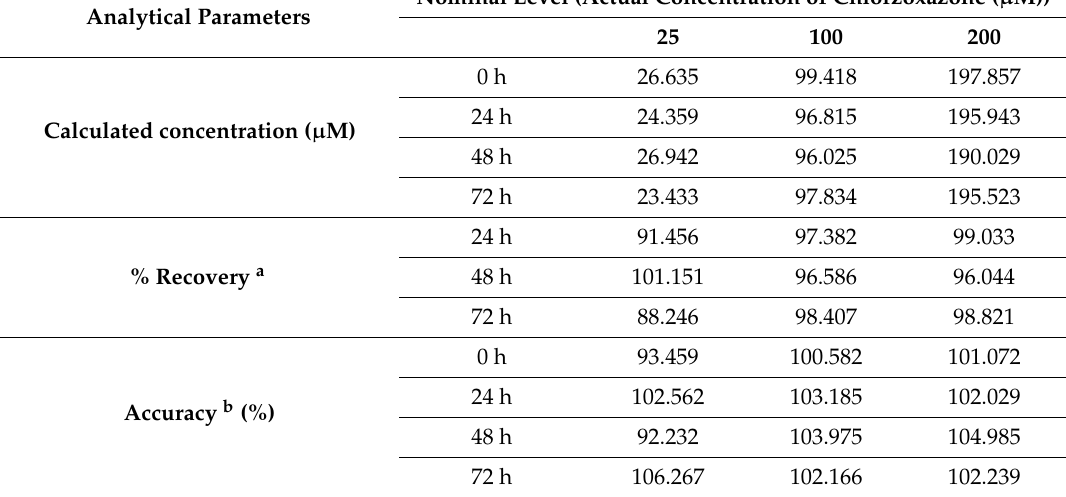
Table 7. Stability test data of